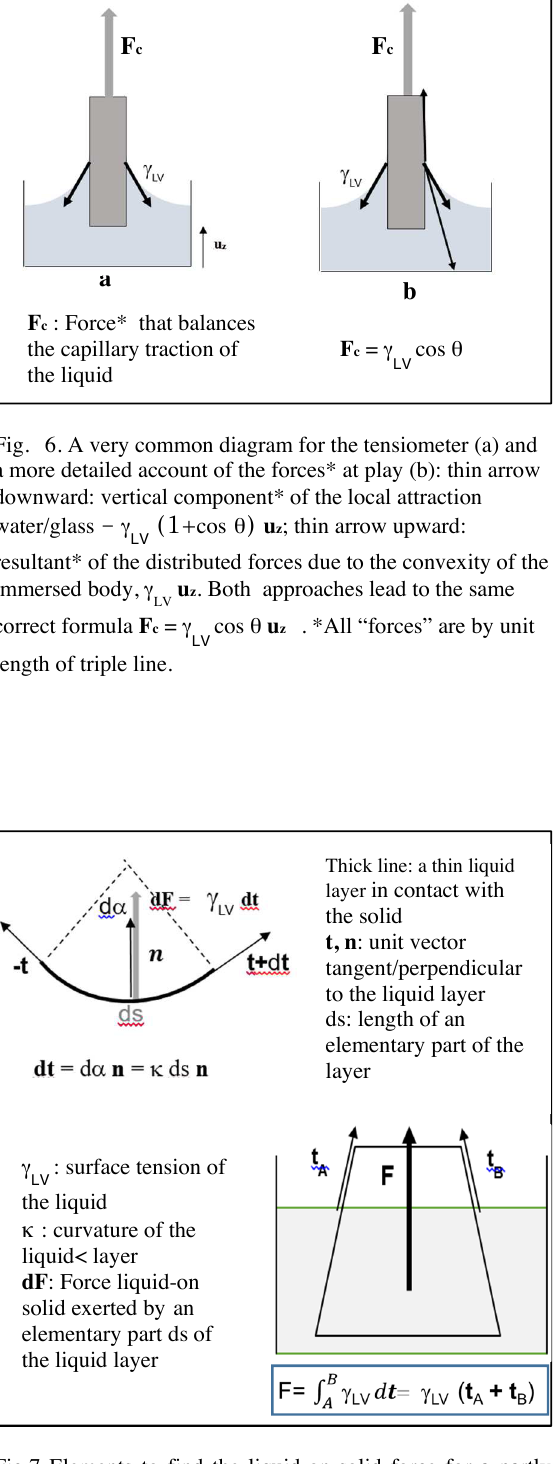
Fig.7 Elements to find the liquid-on-solid force for a partly submerged body